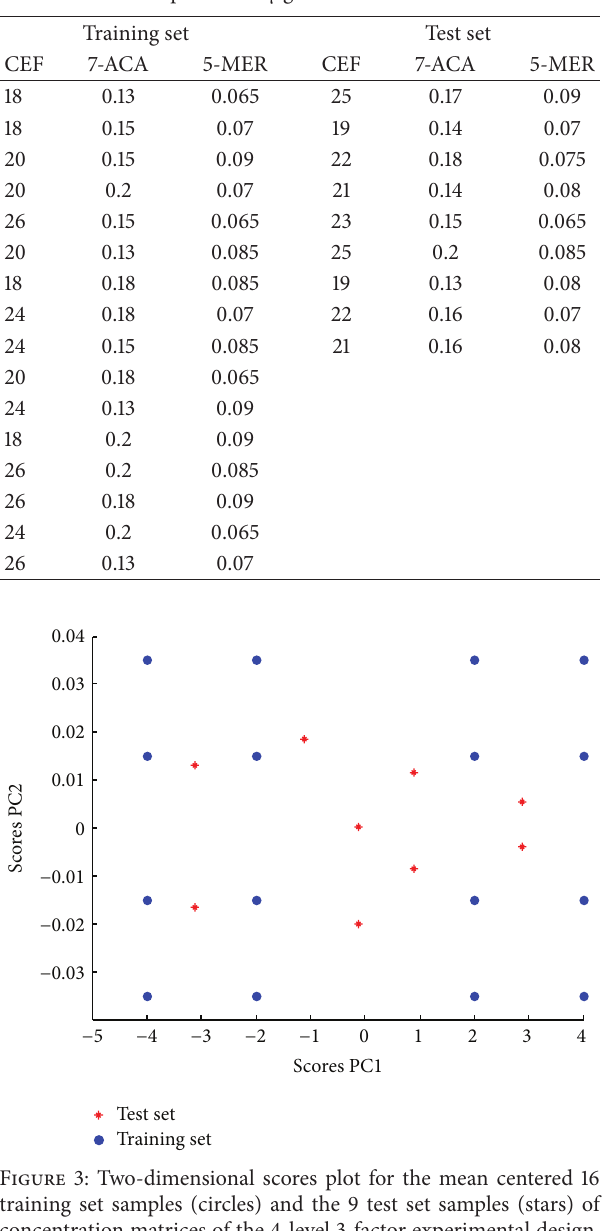
were attained by preparing nine independent mixtures other than the training set mixtures but within the concentration space of the adopted design as indicated in Table 1. The well positioning of the mixtures of both training set (circles) and test set mixtures (stars) is indicated in Figure